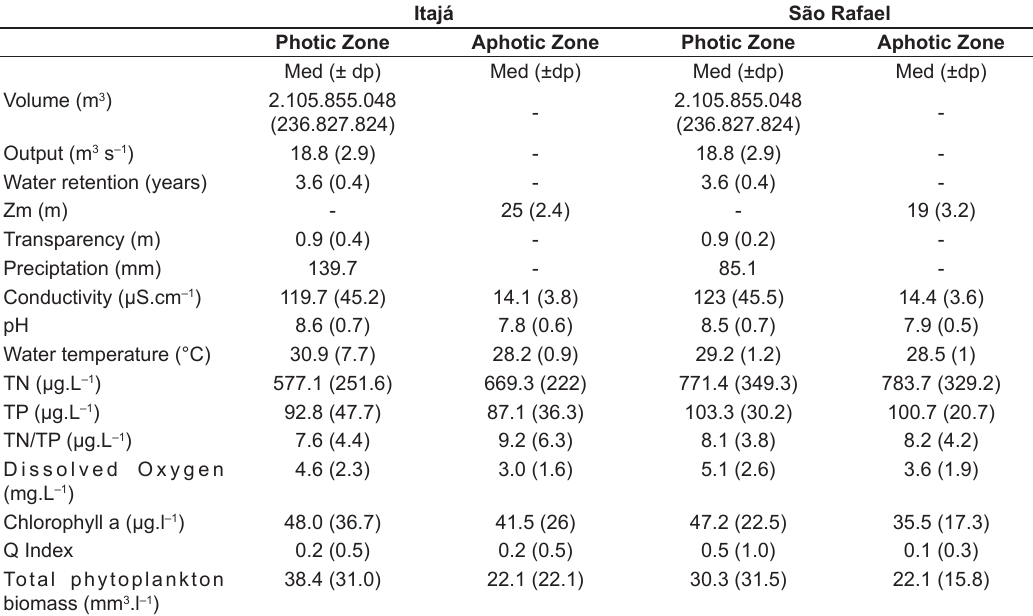
Figure 2. The Modified Carlson’s Trophic State Index (Toledo Junior, 1990), showing the temporal variation of transparency (Secchi), chlorophyll-a (CHL) and Total phosphorus (TP) for points 1 (a) and 2 (b) at Armando Ribeiro Gonçalves reservoir between 2009 and 2011. Table 1. Mean and standard deviaton of the abiotic and biotic variables in the Armando Ribeiro reservoir between 2099 and